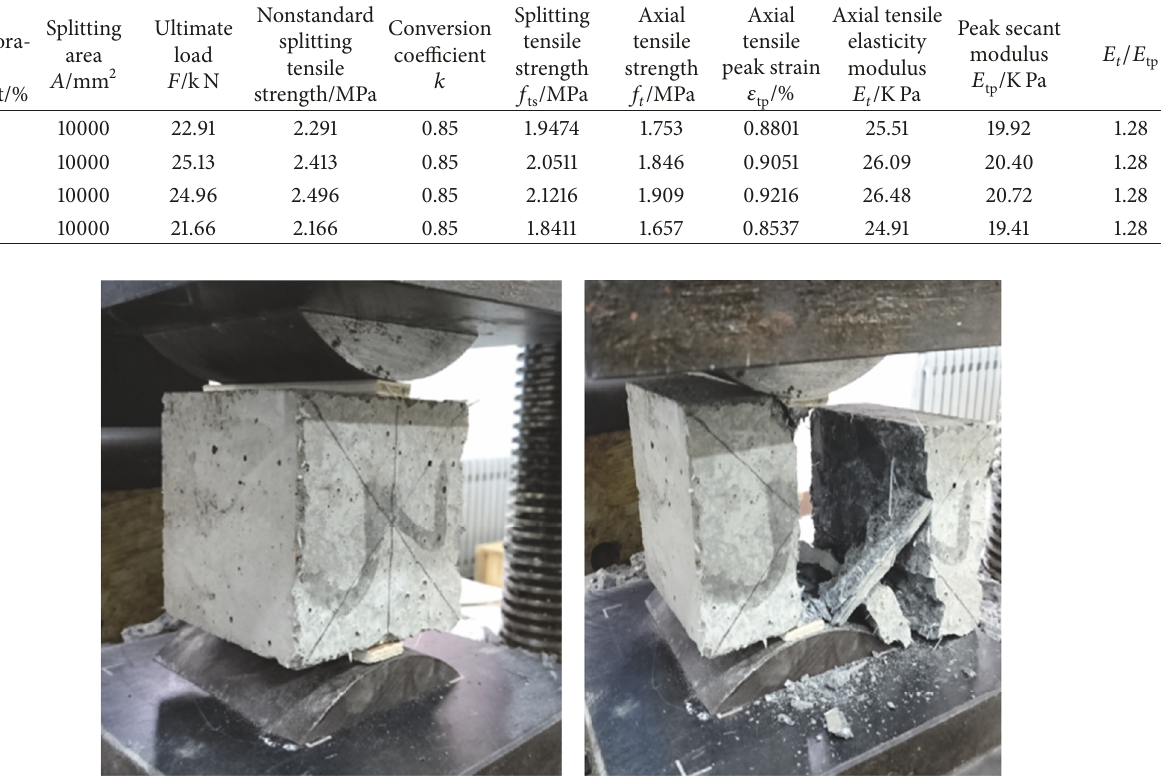
Figure 4: Splitting tensile strength test in this experiment.